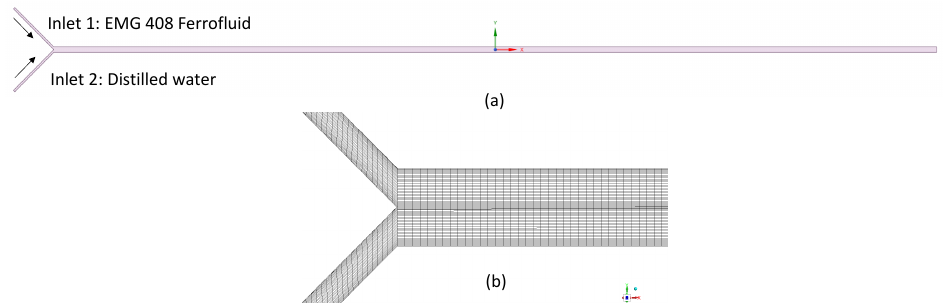
Figure 4. ( a ) Computational domain; ( b ) Mesh near the entrance of microfluidic